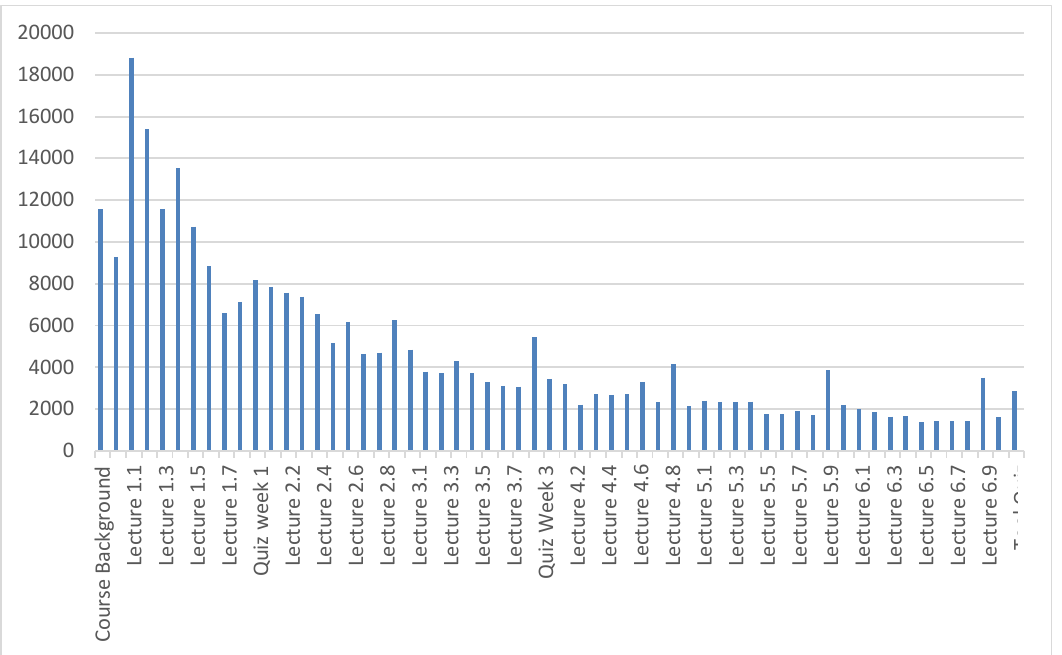
Figure 2. Number of recorded events per activity (e.g., lecture, quiz; sorted by order of expected execution). X-axis items show alternating materials; bars show all consecutive materials.